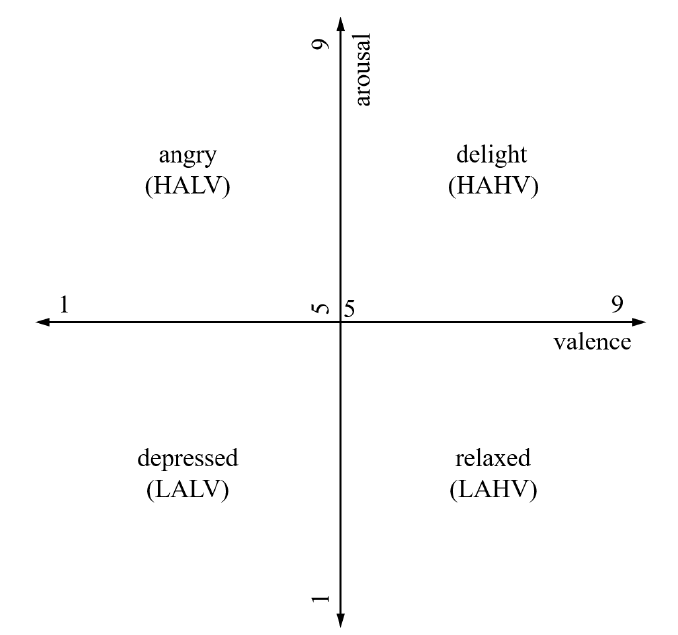
Figure 2. Valence and arousal on two-dimensional plane, where the valence and arousal are represented along the horizontal and vertical axes, respectively.